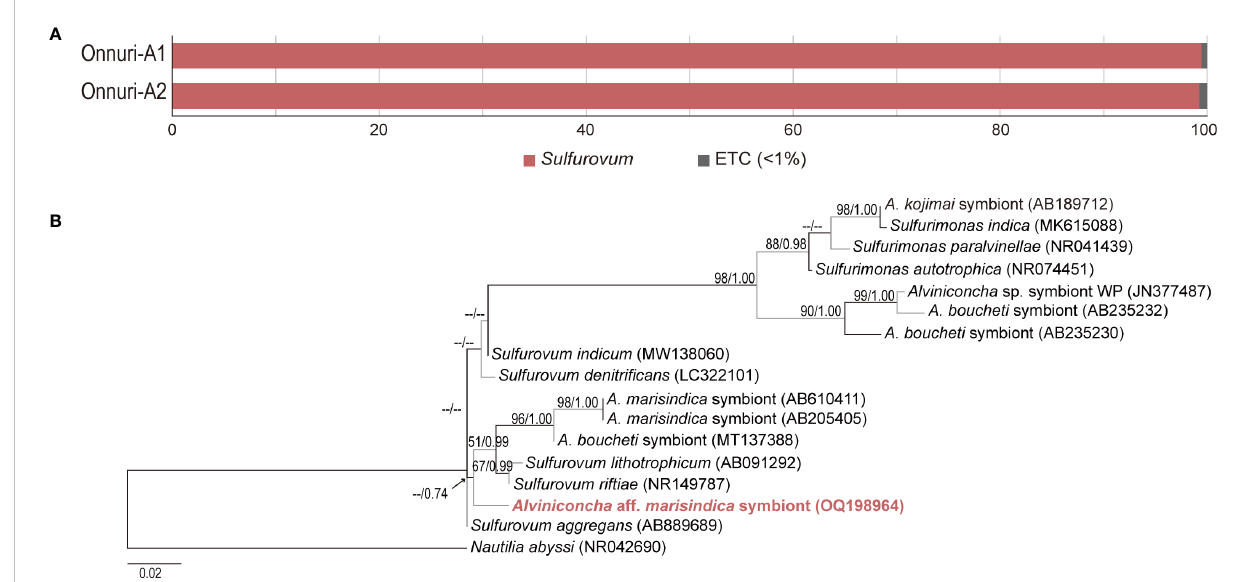
FIGURE 5 Relative abundance of gill-associated symbiotic bacteria and phylogenetic tree of dominant symbiont based on 16S rRNA sequences. (A) At the genus level, bacterial community compositions in gill tissue of Alviniconcha snails from the Onnuri vent fi eld. (B) Phylogenetic relationship among gill-association bacteria of Alviniconcha